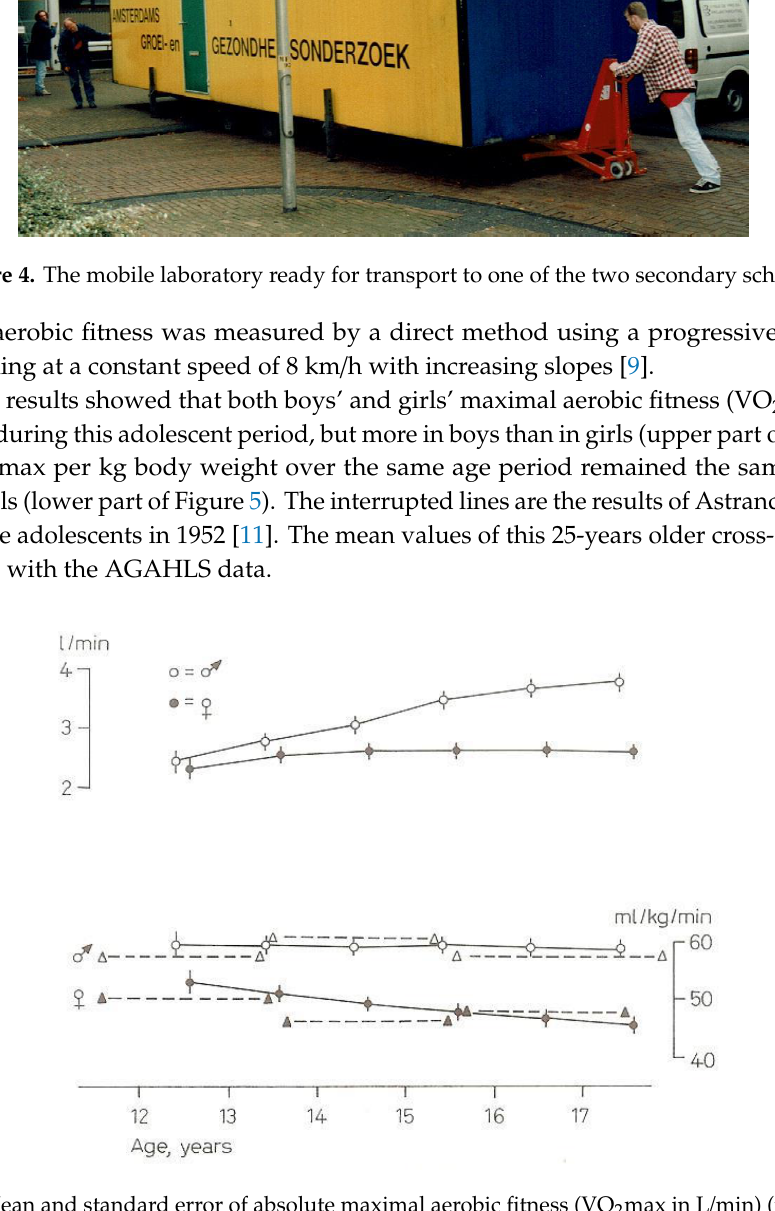
Figure 5. Mean and standard error of absolute maximal aerobic fitness (VO 2 max in L/min) (upper part) and relative maximal aerobic fitness (VO 2 max/BW (ml/kg/min) (lower part) in boys and girls versus calendar age [10]. Interrupted lines indicate the results of Astrand [11].